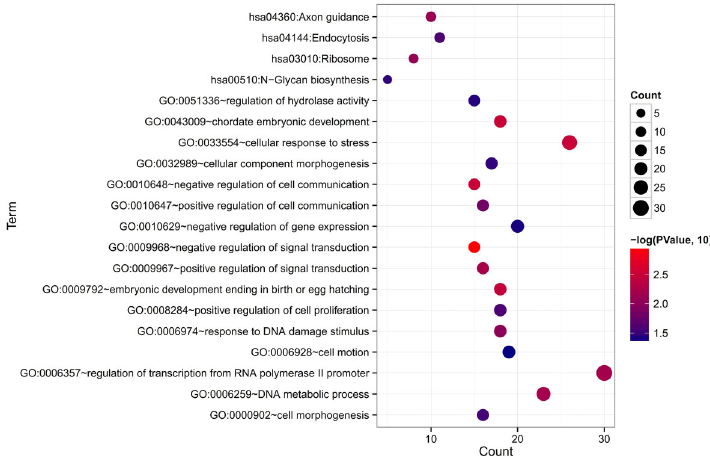
Figure 3. Functional enrichment results for genes in the competing endogenous RNA network. GO: Gene Ontology.